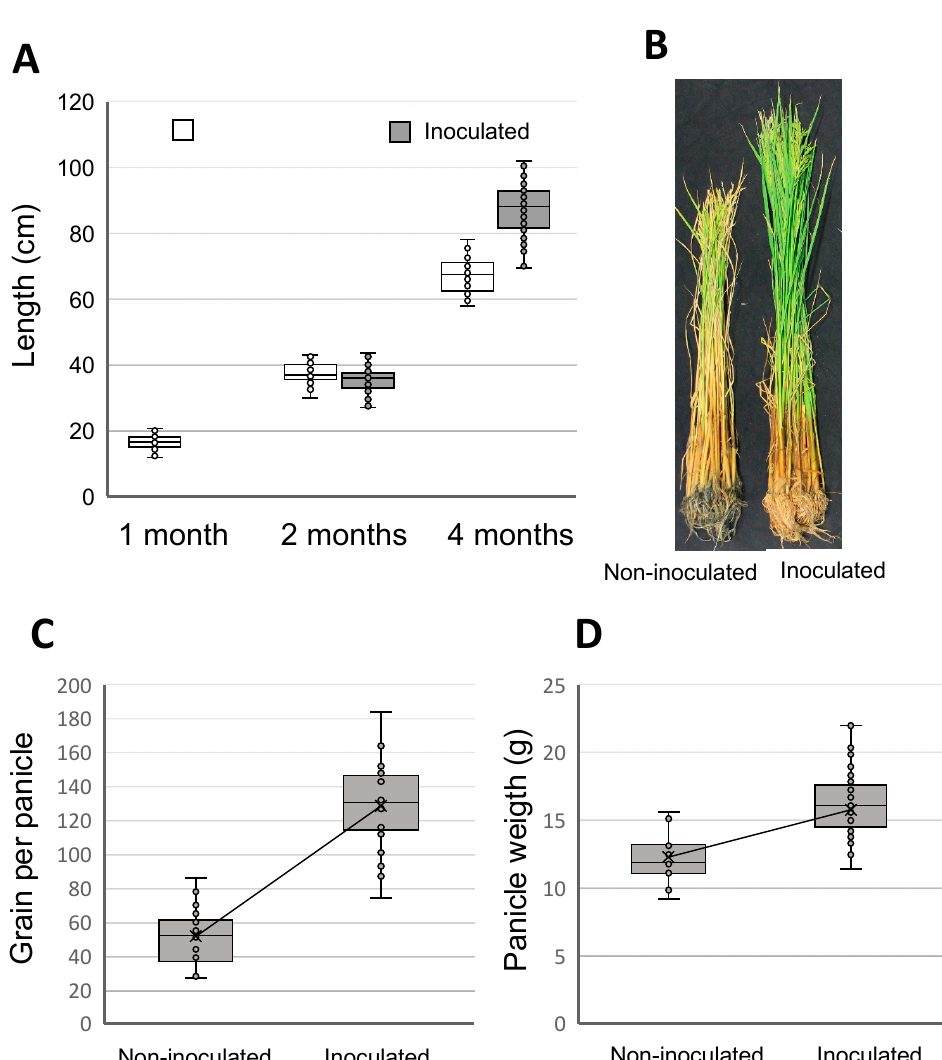
Figure 5. Effect of biofertilization with the cyanobacterial consortia in rice field trials. ( A ) Length of aerial part of rice plants measured at different plant developmental stages. T-Student test revealed a significant difference between treated and non-treated plants at 4 months ( p = 1.22 × 10 − 26 ). ( B ) Plants collected at 4 months after planting were photographed. The same number of plants are shown in each treatment. ( C ) Effect of the cyanobacterial biofertilizer on the number of grains per panicle. T-Student reveals a significant difference between treated and non-treated plants ( p = 3.79 × 10 − 6 ). ( D ) Effect of the cyanobacterial biofertilizer on the weight of the panicle. T-Student reveals a significant difference between treated and non-treated plants ( p = 4.93 × 10 − 13 ).